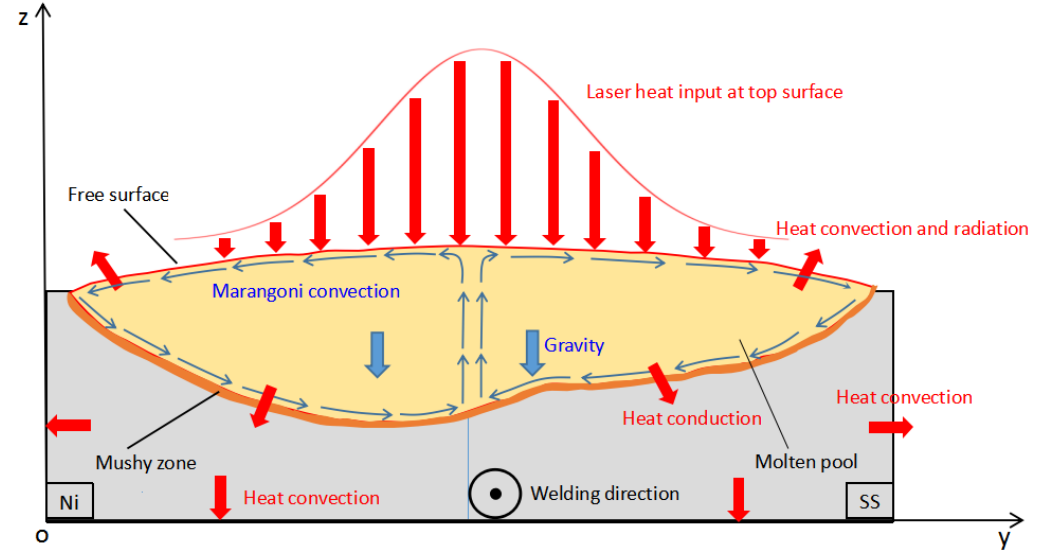
Figure 2. Schematic sketch of laser dissimilar welding.